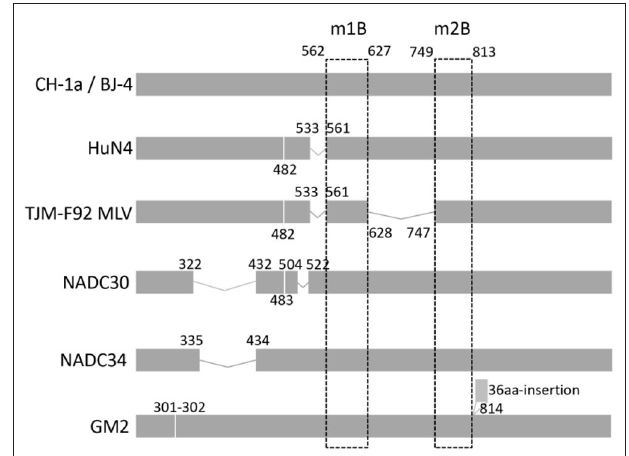
FIGURE 2 | Insertions and deletions in NSP2 of circulating PRRSV-2 or the MLV strain. VR-2332, the prototype of PRRSV-2, was used as a representative strain. Strains are listed on the left. The positions labeled in the figure are preferred to the corresponding position in VR-2332. Two regions (named m1B and m2B) at 562–627 and 749–813 are universal in PRRSV-2. On the left is the name of the representative strain of each indel